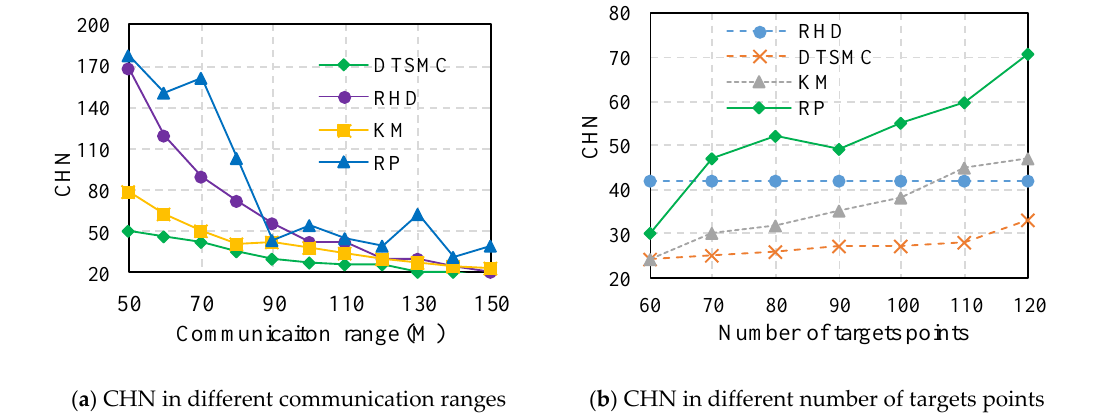
Figure 3. The results of CHN in different methods .